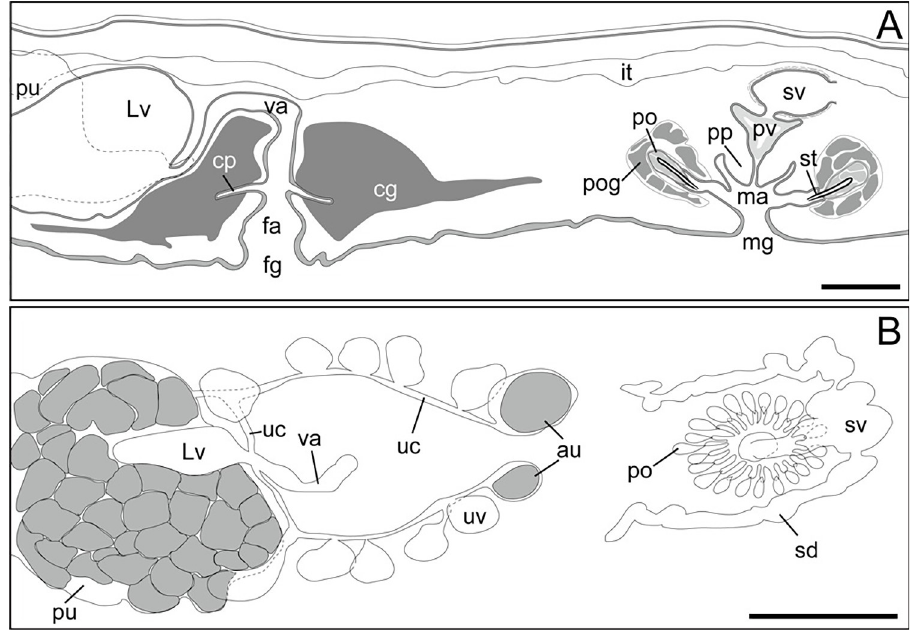
Fig 5. Schematic diagrams of Boninia yambarensis sp. nov. (anterior to the right). (A) ICHUM 8284 (holotype), sagittal view of copulatory complex; (B) ICHUM 8285 (paratype), histological view of copulatory complex. Abbreviations: au, anterior dilation of uterus; cg, cement glands; cp, cement pouch; fa, female atrium; fg, female gonopore; it, intestine; Lv, Lang’s vesicle; ma, male atrium; mg, male gonopore; po, prostatoid organ; pog, prostatoid organ glands; pp, penis papilla; pu, posterior dilation of uterus; pv, prostatoid vesicle; sd, sperm duct; st, stylet; sv, seminal vesicle; uc, uterine canal; uv, uterine vesicle; va, vagina. Scale bars: A, 100 μ m; B, 300 μ m.